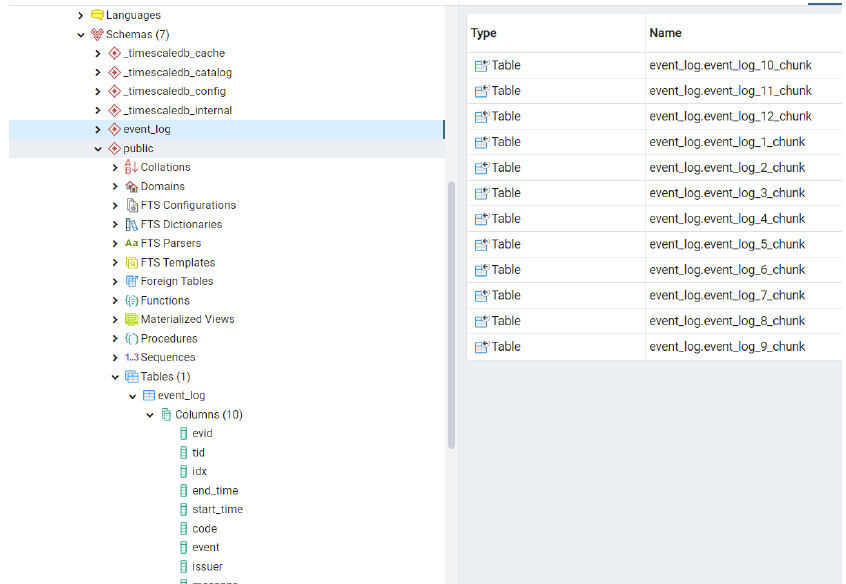
Figure 4. Chunk (Physical